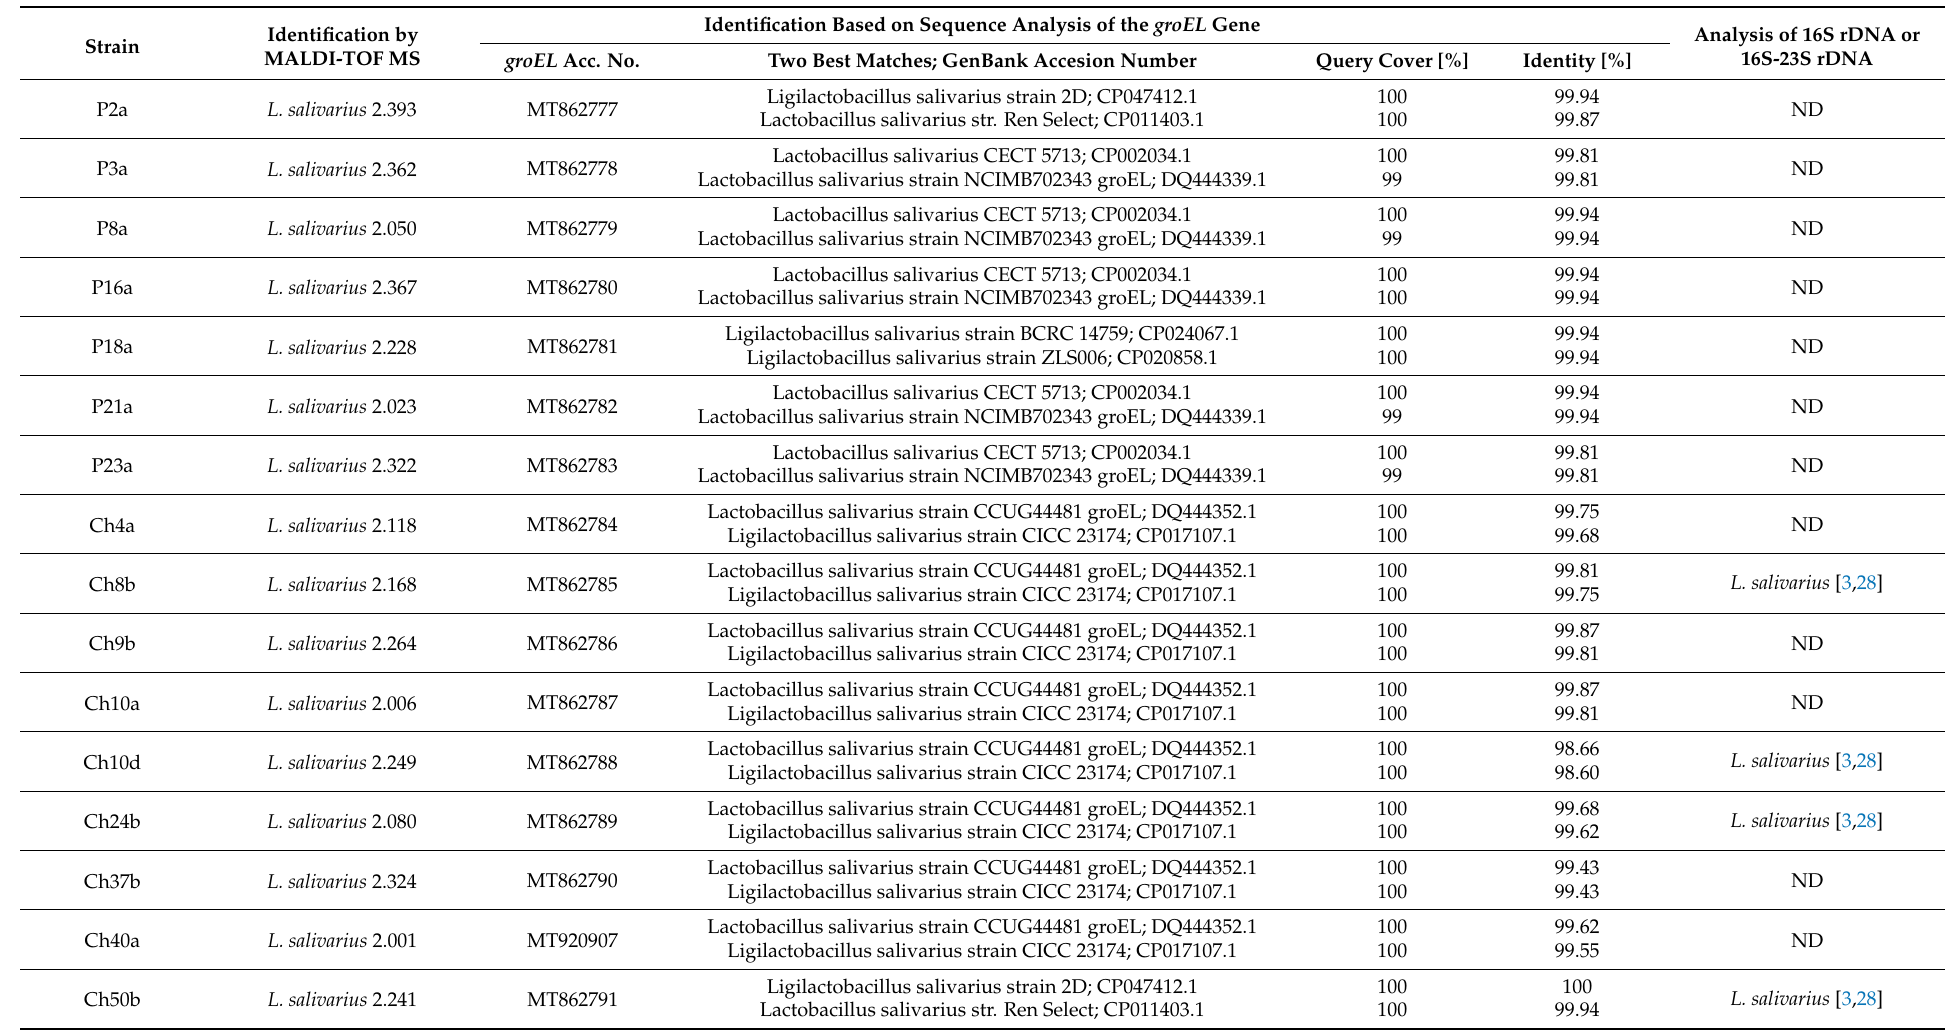
Table A1. Identification of L. salivarius strains by MALDI-TOF mass spectrometry, groEL sequence analysis and analysis of 16S rDNA or 16S-23S rDNA regions. Identification Based on Sequence Analysis of the groEL Identification by Strain MALDI-TOF MS